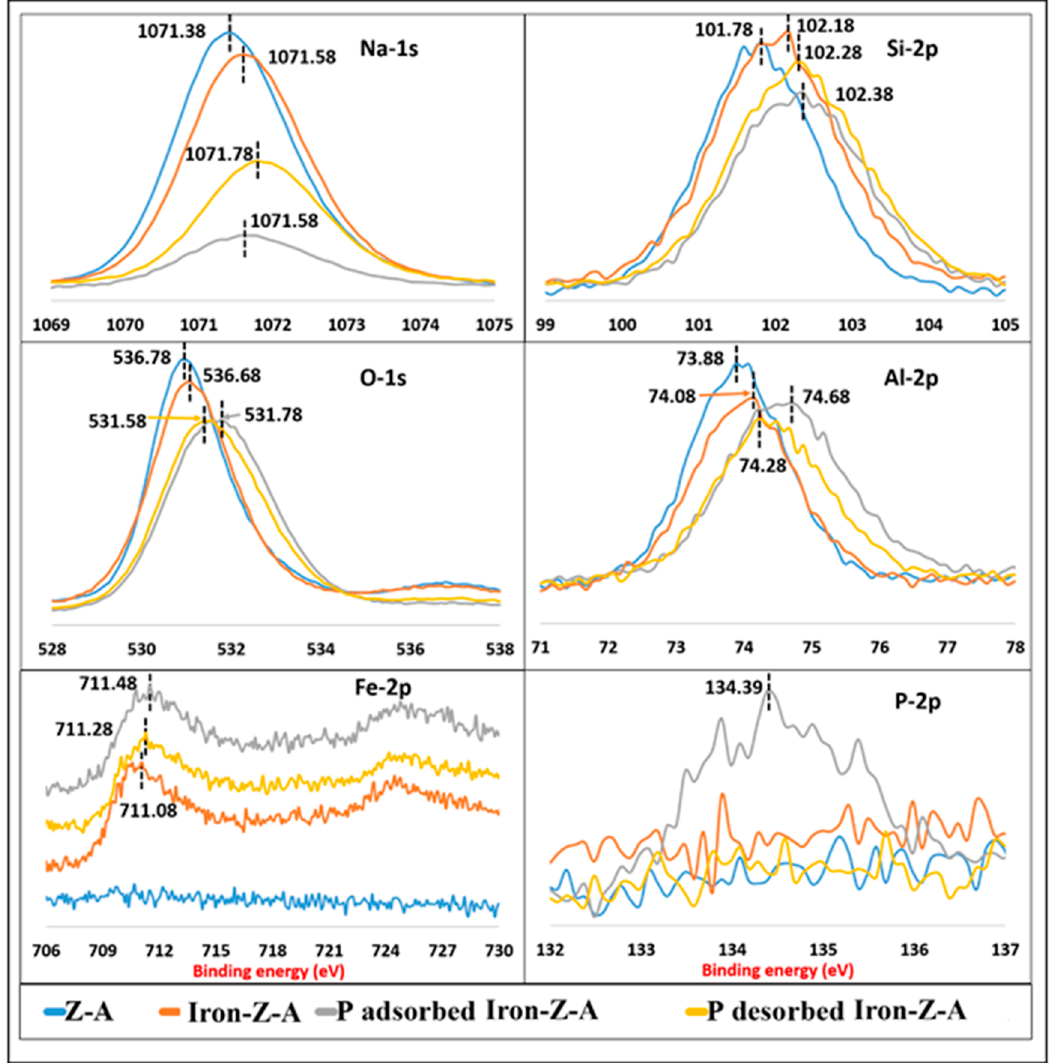
Figure 5. Illustration of XPS spectra of Na 1s, Si 2p, O 1s, Al 2p, Fe 2p, and P 2p in the framework of fresh Z-A, fresh iron-zeolite-A (Iron-Z-A), P-adsorbed Iron-Z-A, and P-desorbed Iron-Z-A.